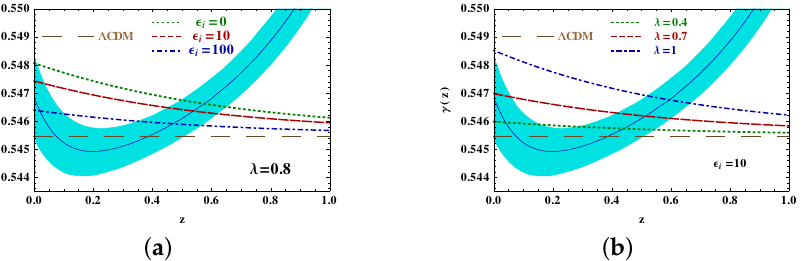
Figure 5. Evolution of γ ( z ) has been shown. The shaded region is the 1 σ uncertainty in the recon- structed γ ( z ) from the Pantheon data set of SNIa [73]. The brown (long-dashed) line represents γ ( z ) for Λ CDM. For both of the figures Ω m0 = 0.3. ( a ) Green (dotted), red (dashed), and blue (dot-dashed) curves correspond to (cid:101) i = 0, 10, 100 respectively for the exponential potential with slope λ = 0.8.; ( b ) Green (dotted), red (dashed), and blue (dot dashed) curves correspond to λ = 0.4, 0.7, and 1 respectively. We have kept (cid:101) i =